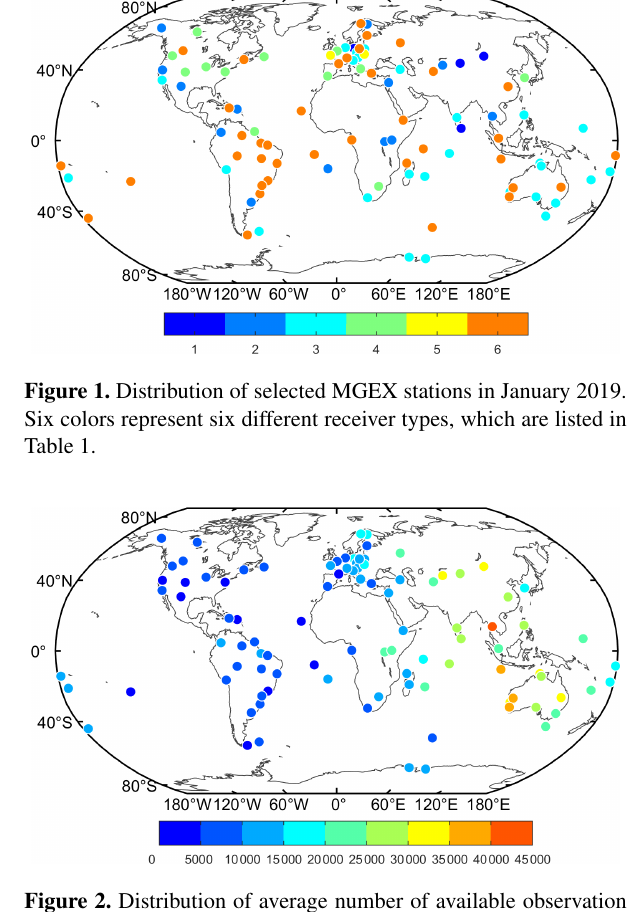
Table 1. Summary of selected MGEX stations in January 2019.